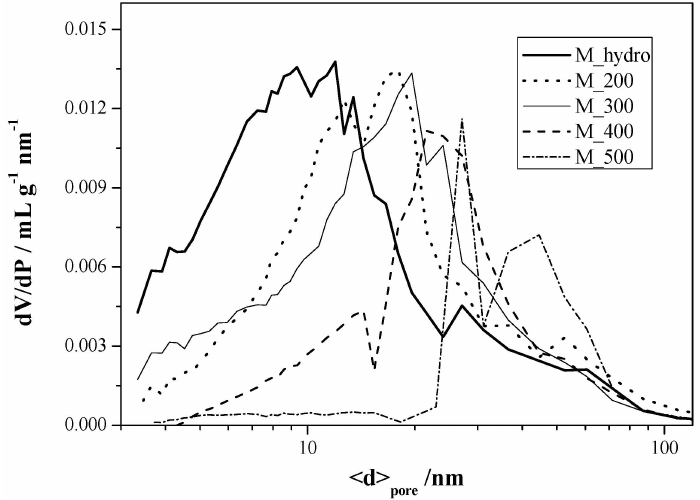
Figure 2. Comparison of the pore size distribution (calculated by the Barrett Joyner Halenda (BJH) method) of MnO 2 powders at increasing calcination